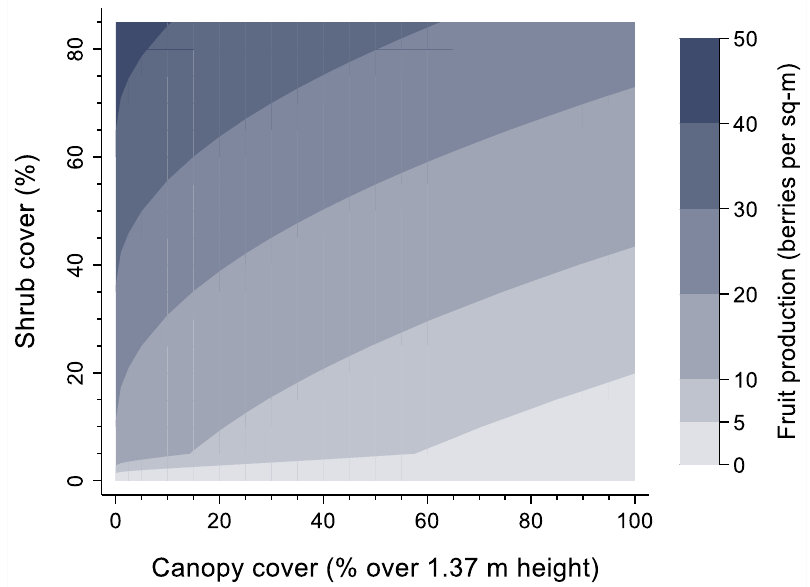
Figure 4. Predicted average fruit production (berries / m 2 ) of velvet-leaf blueberry as a function of forest canopy cover measured from Airborne Laser Scanning (ALS) data (fraction of first returns at > 1.37 m height) and blueberry shrub cover. All other variables were held at their mean.